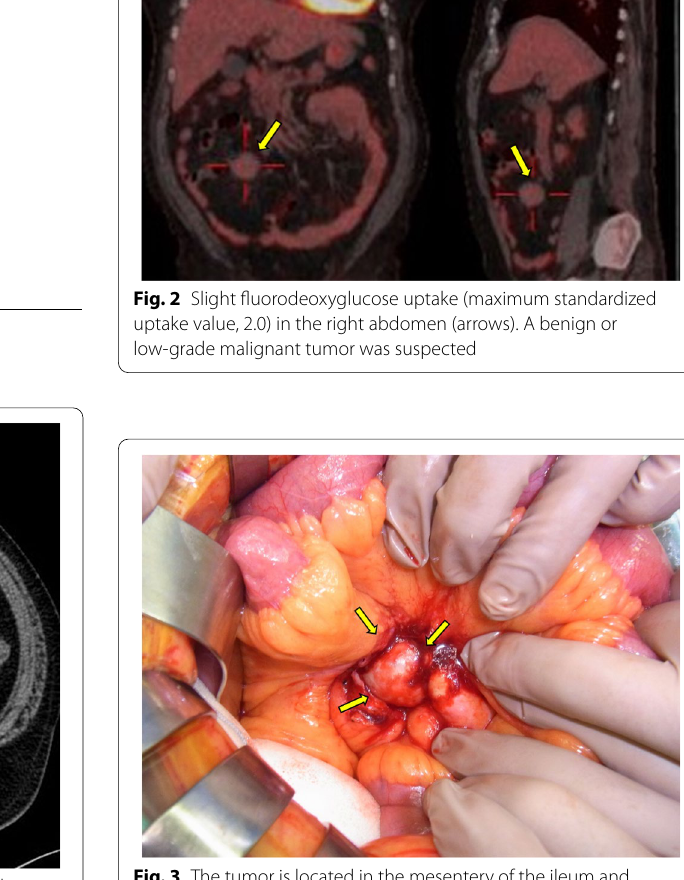
Fig. 1 Contrast-enhanced computed tomography of the abdomen reveals a mesenteric lobulated mass with an artery running through the center (arrow)